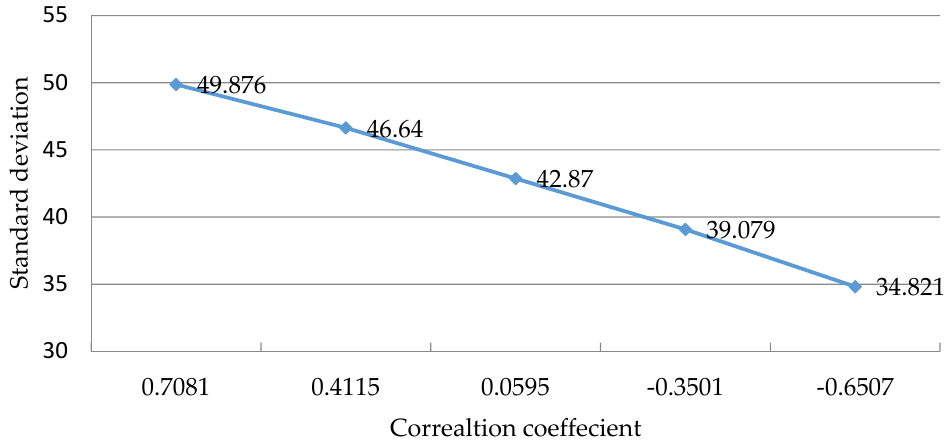
Figure 5. Standard deviations of wind power series with different correlation coefficient.